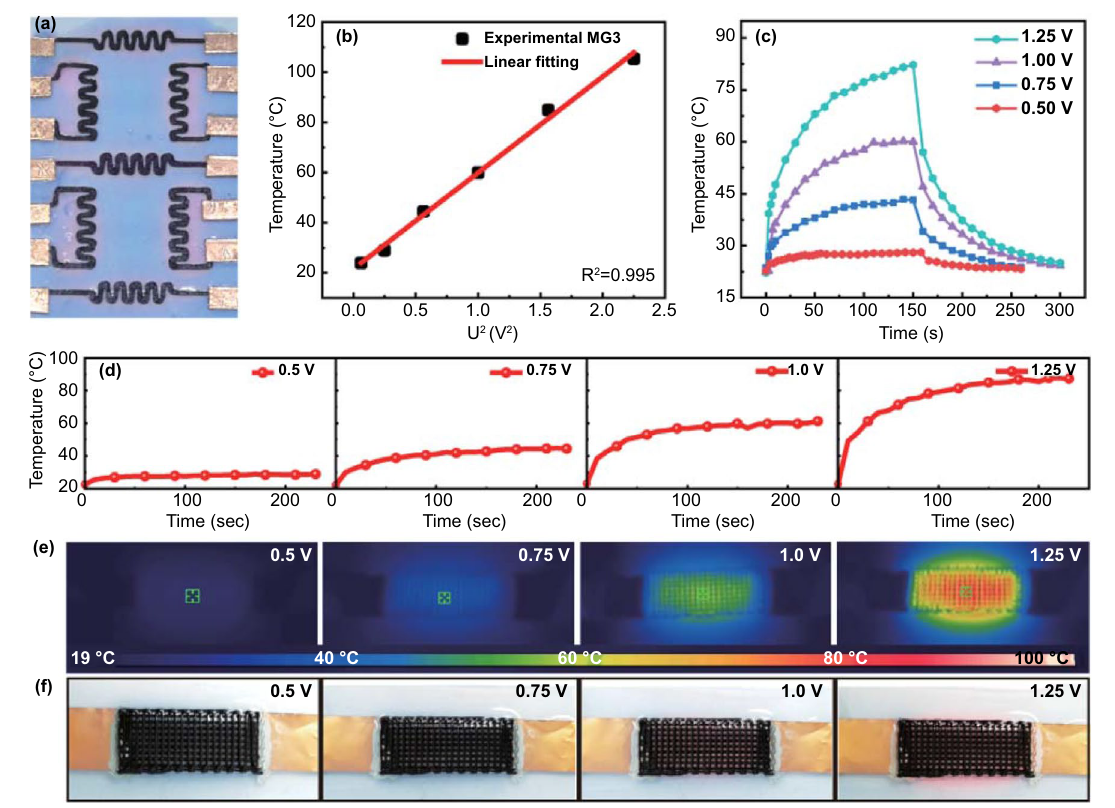
Fig. 6 Electric thermal performances of printed MG3. a Digital photograph of printed thermochromic pattern. b Relationship between satura‑ tion temperature and U 2 for MG3 pattern. c Time‑dependent surface temperatures under different voltages. d Joule heating performances of MG3 pattern, e infrared thermal imaging photographs, and f color changes of electro‑thermochromic MG3 pattern under related